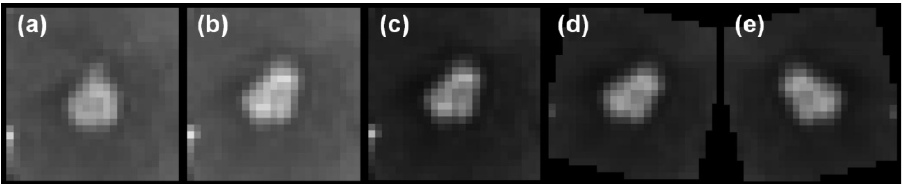
Figure 3. The data noising process. ( a ) Mid-axial slice of an original cropped sample. ( b ) Random elastic deformation, ( c ) random gamma correction, ( d ) random image rotation, and ( e ) random image flip are applied.